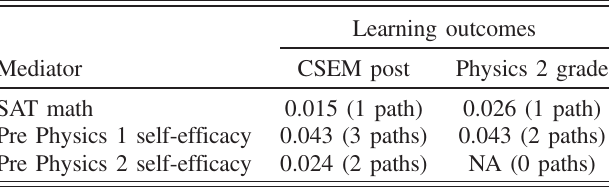
TABLE VI. Total indirect gender effects on learning outcomes through SAT math, pre Physics 1 SE, and pre Physics 2 SE. NA indicates nonapplicable.